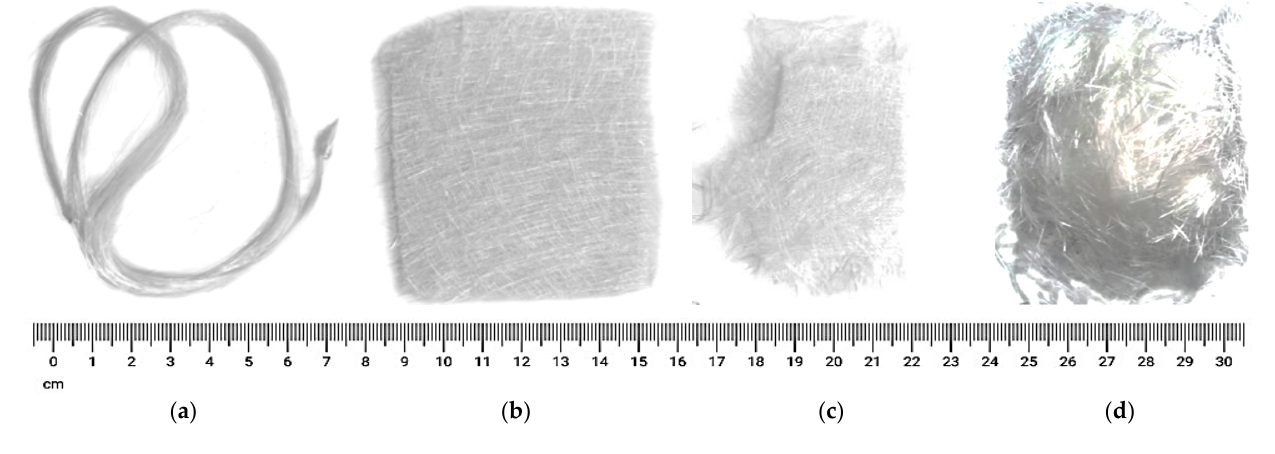
Figure 2. Types of glass fibers: continuously long threaded ( a ), woven and random ( b ), chopped strand mat ( c ) and chopped ( d ) fibers. Table 1. Chemical composition, characteristics and main applications of glass